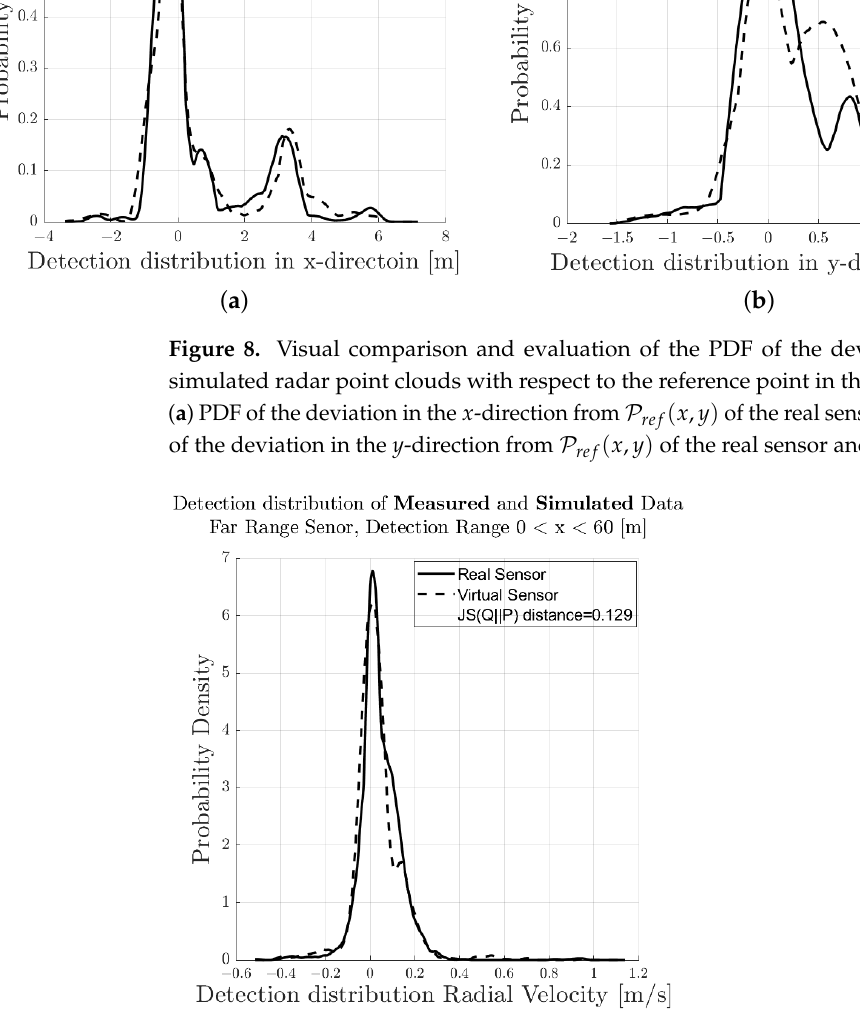
Figure 9. Visual comparison and evaluation of the probability distribution function (PDF) of the devi- ation of the measured and simulated radar point clouds with respect to the reference point P ref ( x , y ) in the near-range detection sector: PDF of the radial velocity deviation from the reference